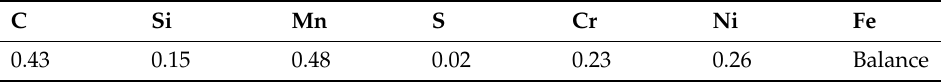
Figure 1. Schematic diagram of the disk-on-disk tribotester and the photo of the pin and disk. Table 3. Chemical compositions of the pin and disk (wt.%).